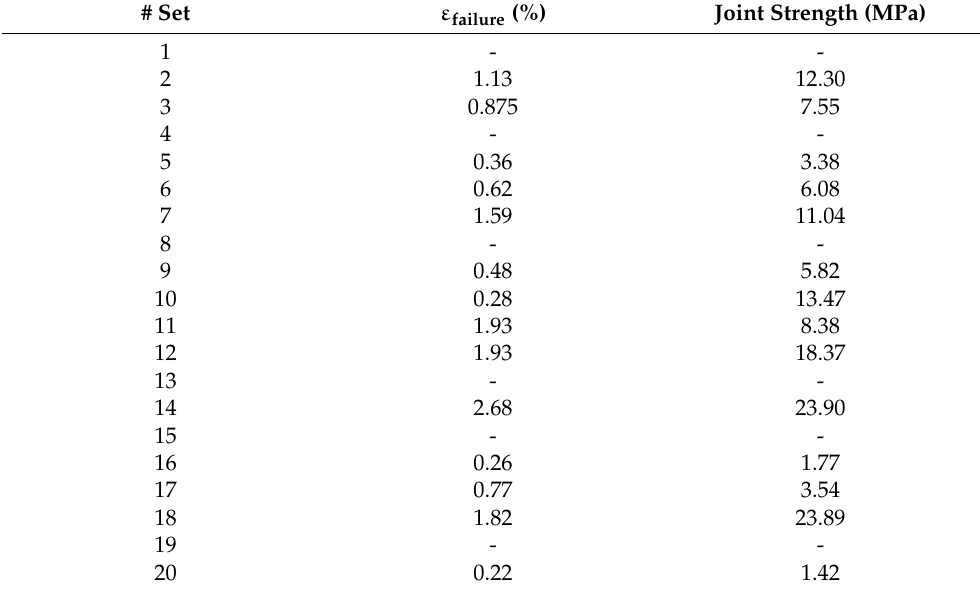
Figure 6. PMMA-steel (without surface physical pre-treatment) welded specimens labelled with the corresponding set of parameters. Table 4. Results from the tensile tests.